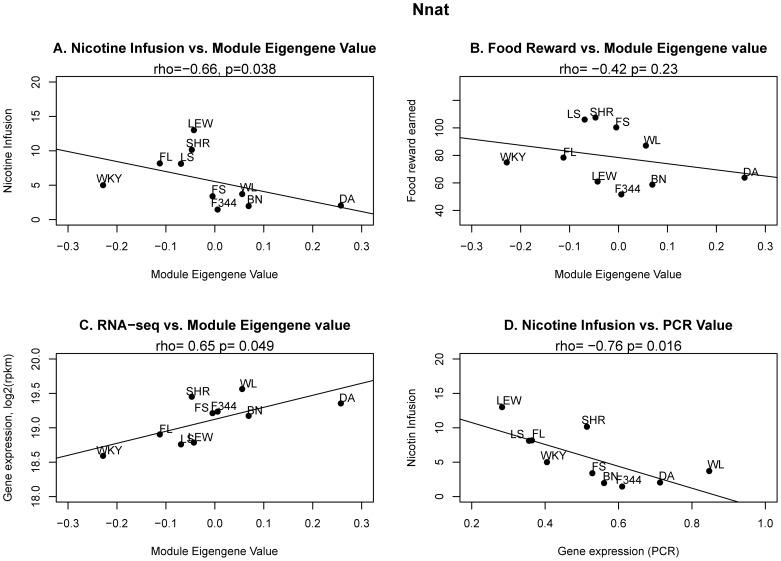
Nnat of the Pink module.The eigenvalue of the Pink module was significantly correlated with nicotine intake (A) but its correlation with food reward earned was not significant (B), suggesting behavioral specificity of the module. Nnat contributed strongly to the expression characteristics of the Pink module (C). The expression pattern of Nnat across the 10 strains measured by PCR showed significant correlation with nicotine intake (D). Strains: BN: Brown Norway, DA: Dark Agouti, F344: Fisher 344, Lew: Lewis, SHR: Spontaneous hypertensive rat, WKY: Wistar-Kyoto. For the F1 hybrids, the two letters representing the initials of the maternal and paternal strains were used.